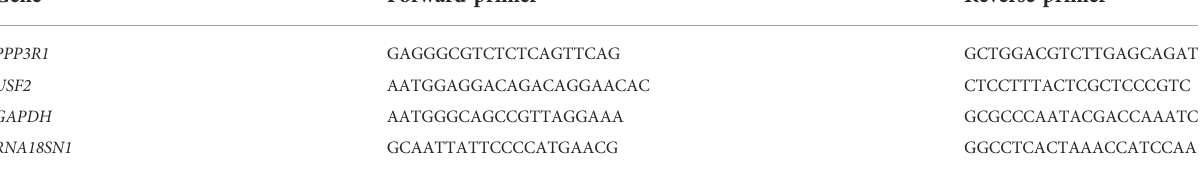
TABLE 1 mRNA primer sequences used for qRT-PCR. Gene